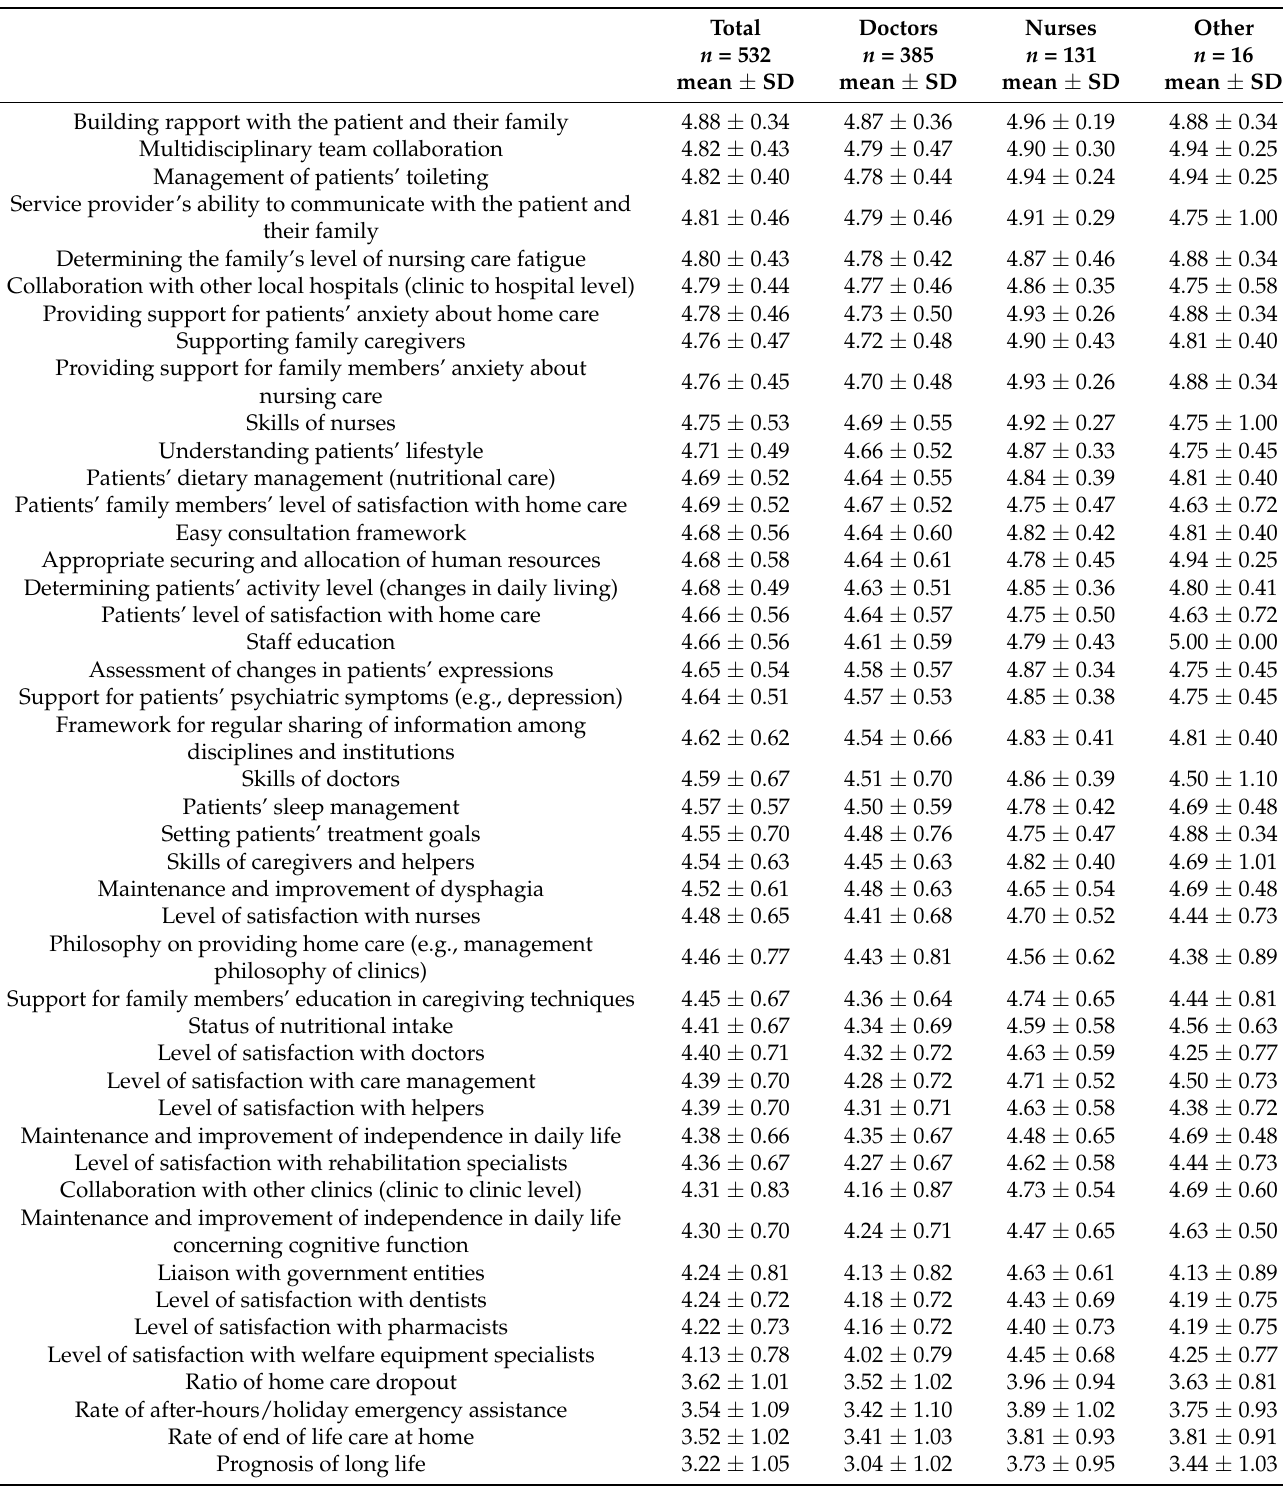
Table 2. The perceptions of home care professionals on evaluating the quality of home